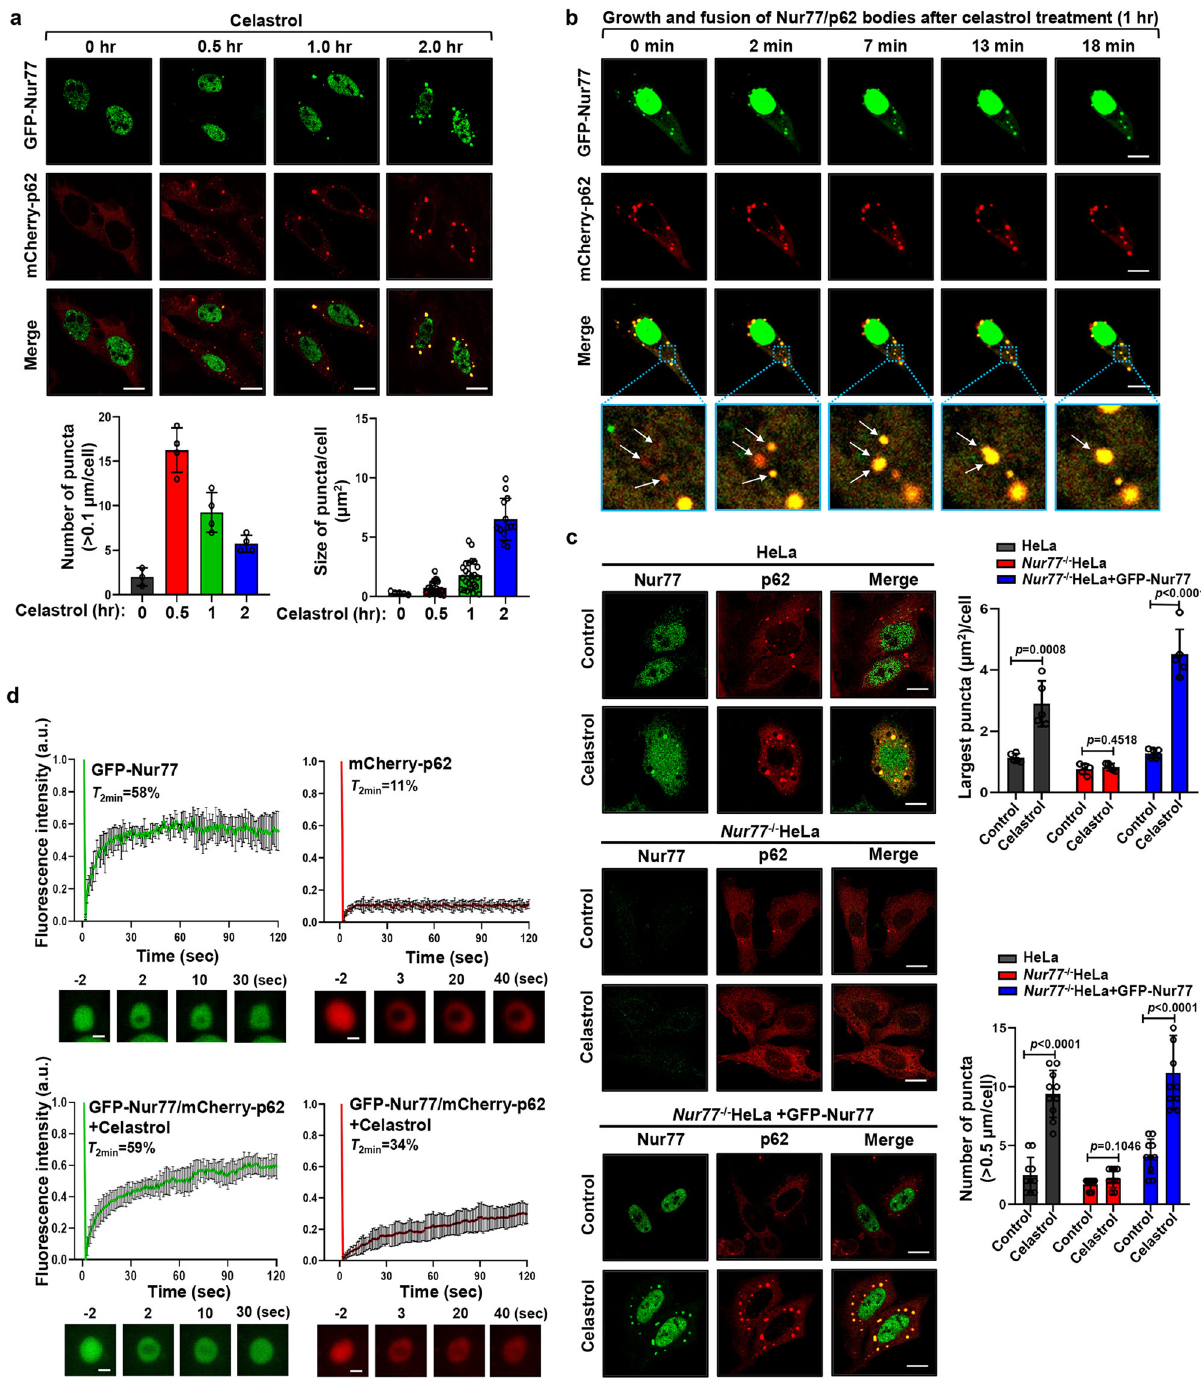
Fig. 2 Celastrol promotes phase separation and liquidity of p62. a Representative images showing the time-dependent effect on celastrol induction of cytoplasmic Nur77 body formation. Bottom panels: quantitative analysis of the number and size of Nur77/p62 body formation. Bottom left graph, n = 4 biologically independent samples; Bottom right graph, n = 20, 23, 25, and 19, respectively. Data were presented as mean values ± SEM. Scale bar, 10 μ m. b Real-time images showing the formation and fusion of GFP-Nur77 and mCherry-p62 droplets in HeLa cells after treatment with celastrol (2 μ M) for 1 h. White arrows indicate droplets formation and fusion (see also Supplementary Movie 1). Scale bar, 10 μ m. c Representative images illustrating the role of celastrol in promoting p62 body formation in a Nur77-dependent manner immunostaining. Nur77 − / − HeLa cells were also transfected with GFP-Nur77 to determine its effect on p62 body formation. The diameter of the biggest p62 puncta in each cell was measured. The number of p62 puncta >0.5 μ m in each cell was assessed. A two-tailed unpaired Student ’ s t -test was used for statistical analysis, and data are presented as mean values ± SEM ( n = 5 biologically independent samples). d FRAP analysis of the effect of Nur77 in regulating p62 mobility in HeLa cells. Data were presented as means ± SEM ( n = 3 independent experiments). Scale bar, 1.5 μ m. Data represent at least three independent experiments. Source data are provided as a Source Data fi le.